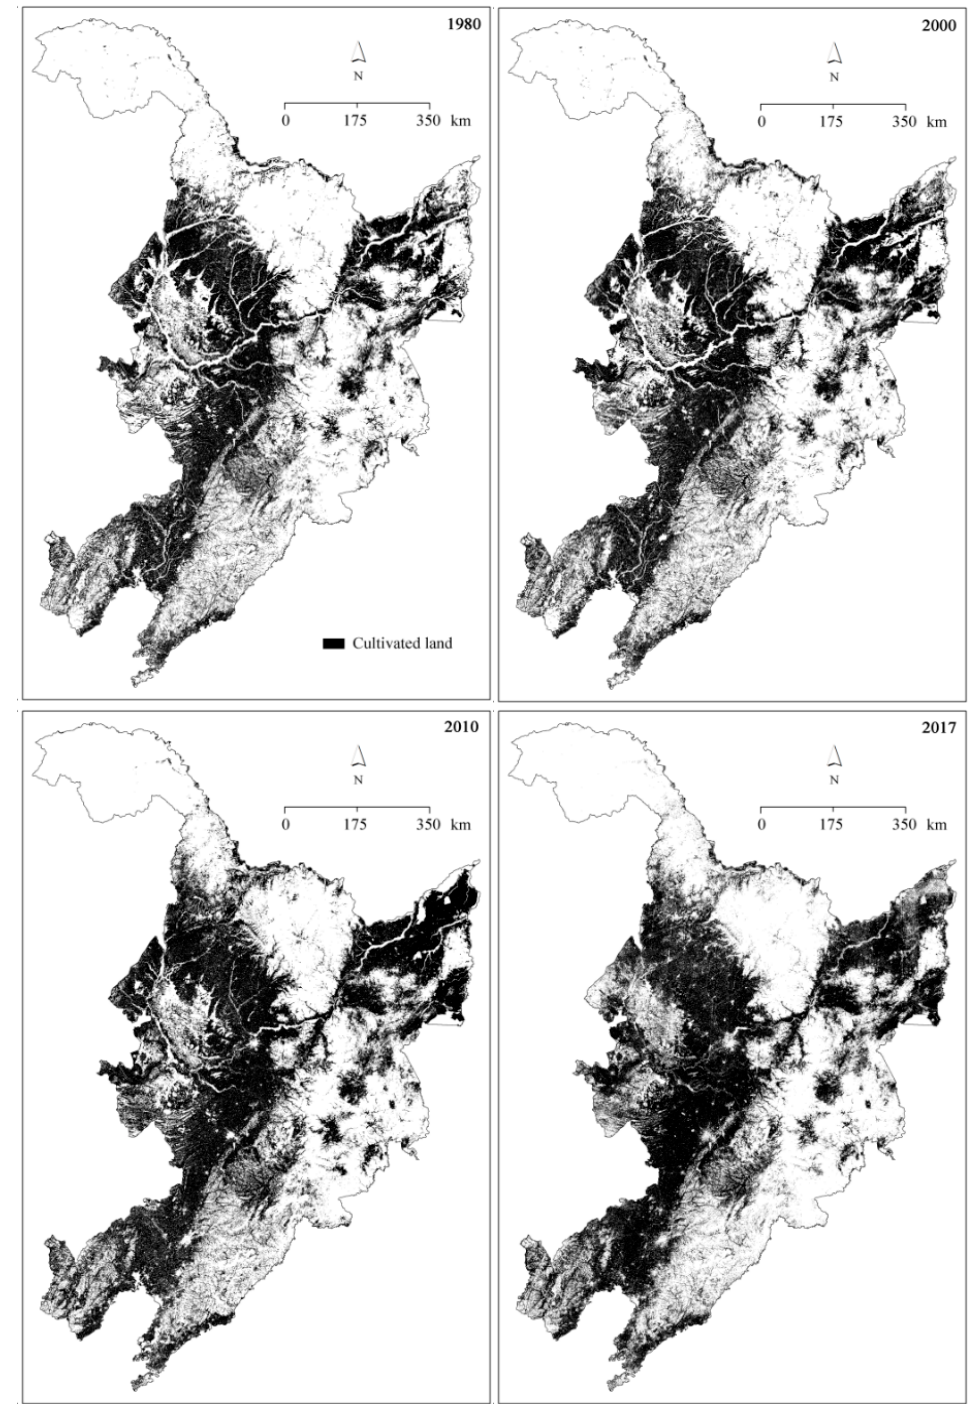
Figure 2. Spatial distribution of cultivated land (black color) in the years 1980, 2000, 2010, and 2017.